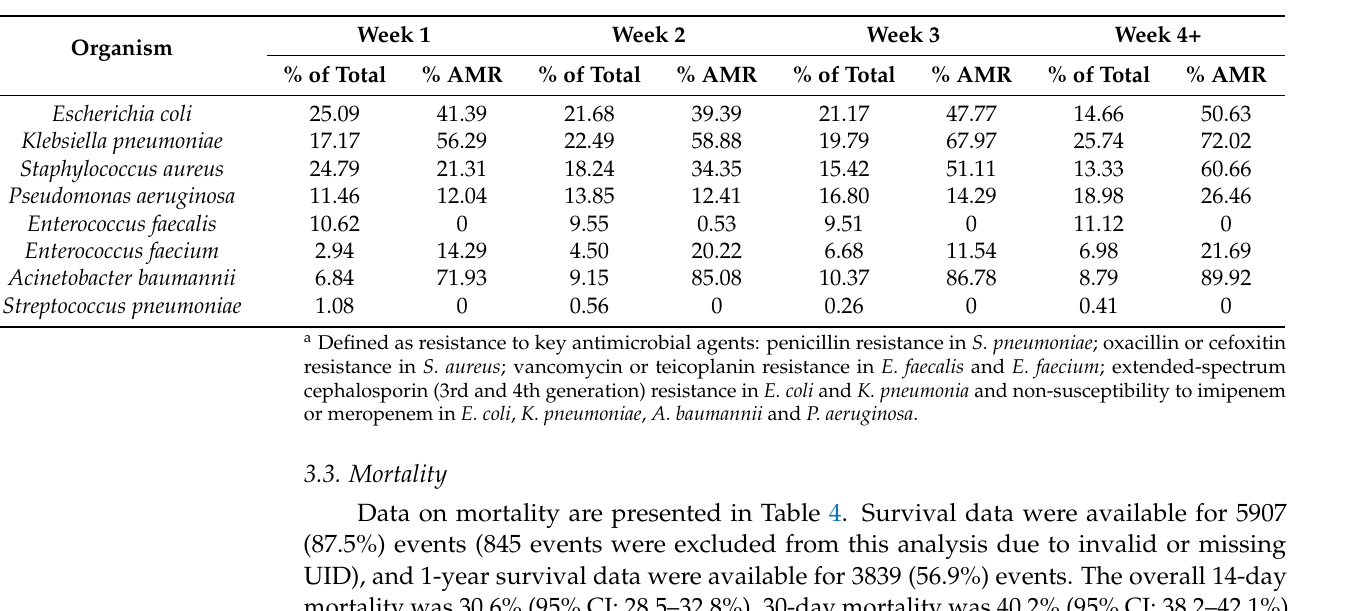
Table 3. Distribution of sentinel organisms by week of hospital-onset bloodstream infection (HO-BSI) onset, and antimicrobial resistance (AMR) status a